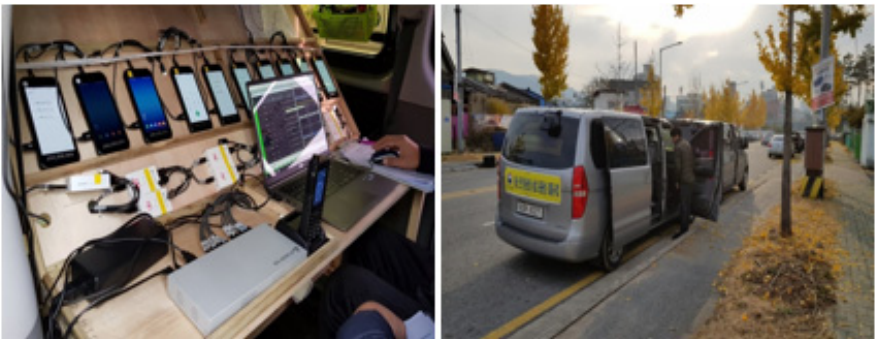
Figure 10. Measuring environment for end-to-end call services.